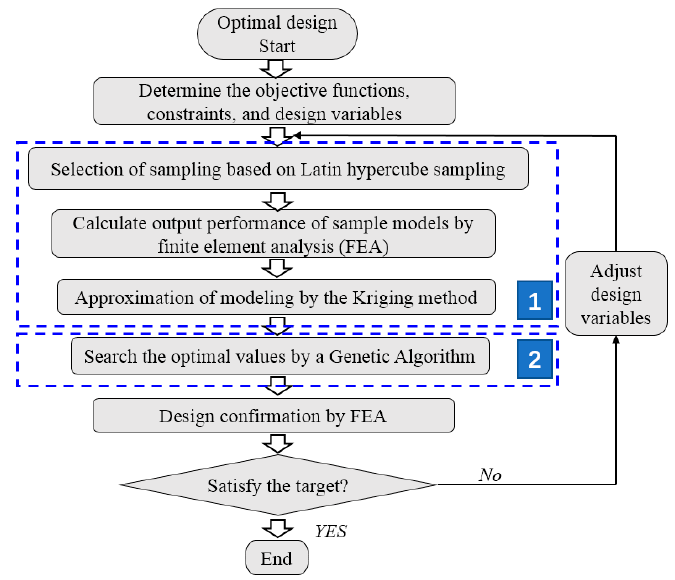
Figure 10. Optimal design process.